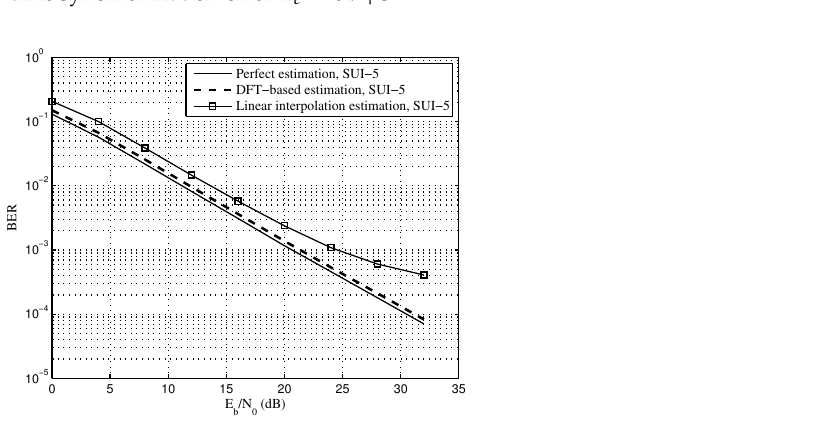
Figure 12. BER of the proposed DFT-based and linear interpolation methods under the SUI-3 channel, time synchronization error L e = 0.9 µ s.